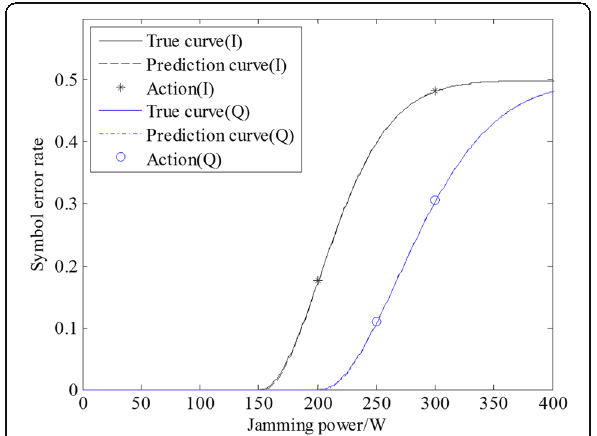
Fig. 5 Environmental noise belongs to the Rayleigh distribution. The predicted results in the in-phase and quadrature phase almost overlapped with the real SER curve, where the noise belongs to Rayleigh distribution, and the dictionary was constructed with the Rayleigh